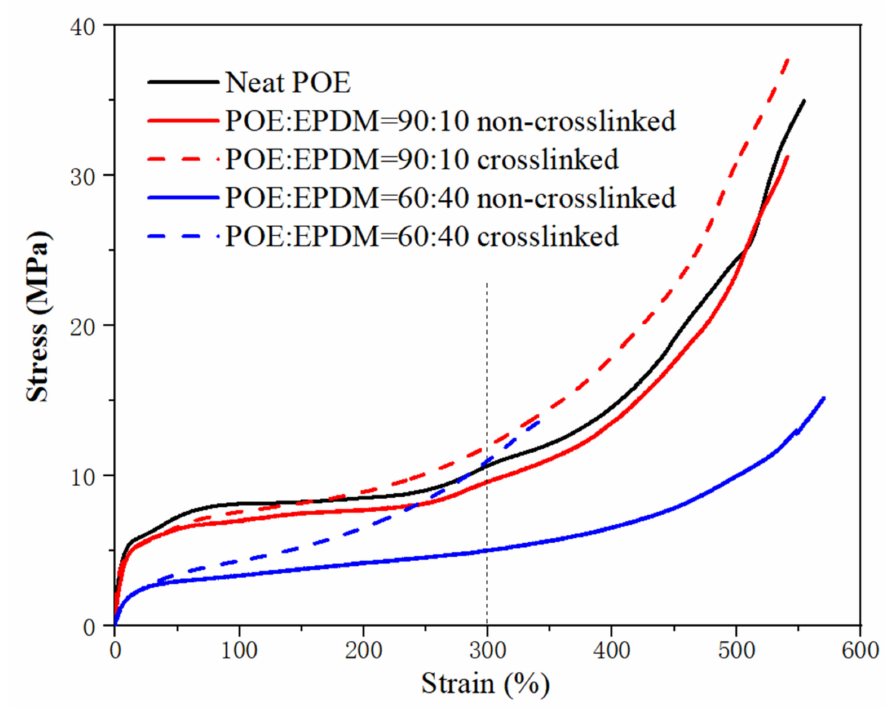
Figure 8. The stress-strain curves (up to break) of neat POE and POE/EPDM